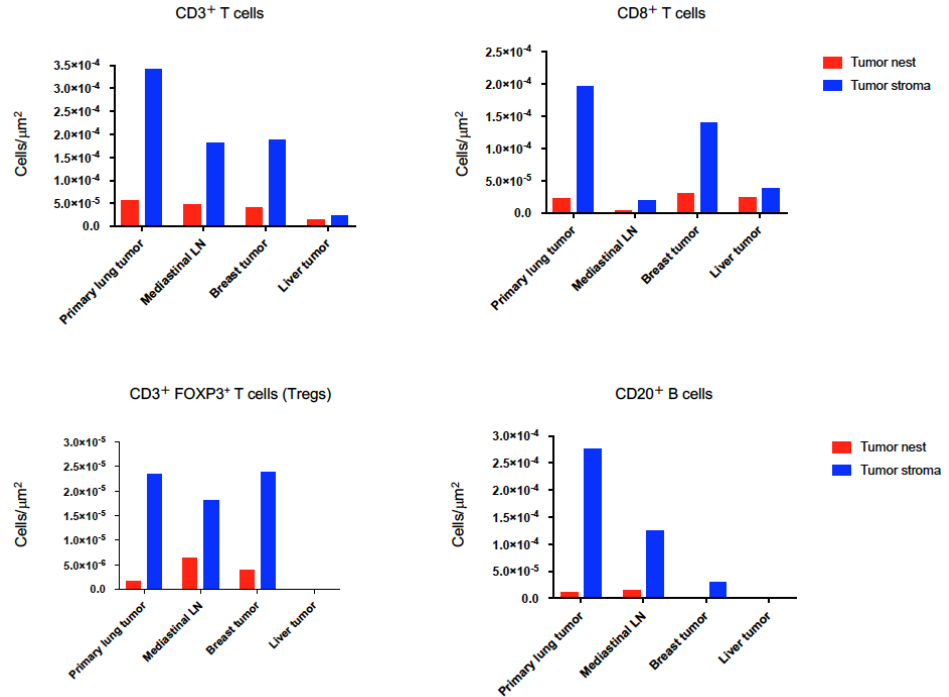
Figure 6. Quantification of CD3 + T cells, CD8 + T cells, CD3 + FOXP3 + T cells (Tregs), and CD20 + B cells. High-speed scanning of whole slide images was performed on stained tissue sections. Images of full sections were acquired and analyzed with automated quantitative pathology imaging system. All images were analyzed and statistics of the number of each types of cells were generated automatically. These tumor-infiltrating lymphocyte (TIL) subsets were separately counted in the tumor cell nest (epithelial compartment) and surrounding stroma under high-power fields. Cells were classified as tumor nest (red bars) or tumor stroma (blue bars) according to the relationship with pan-Cytokeratin-positive tumor